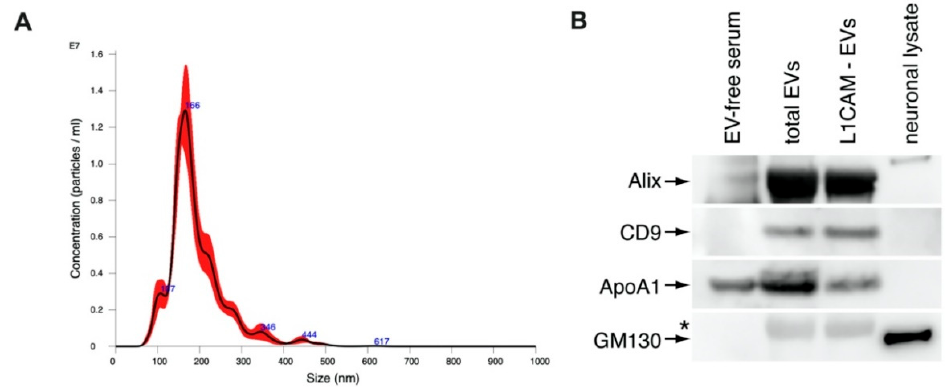
Figure 1. ( A ) NTA analysis of the size distribution of L1CAM-immunoprecipitated NDEVs. ( B ) Im- munoblots of Alix, CD9, ApoA1, and GM130 in total EVs and NDEV samples. * Nonspecific band.